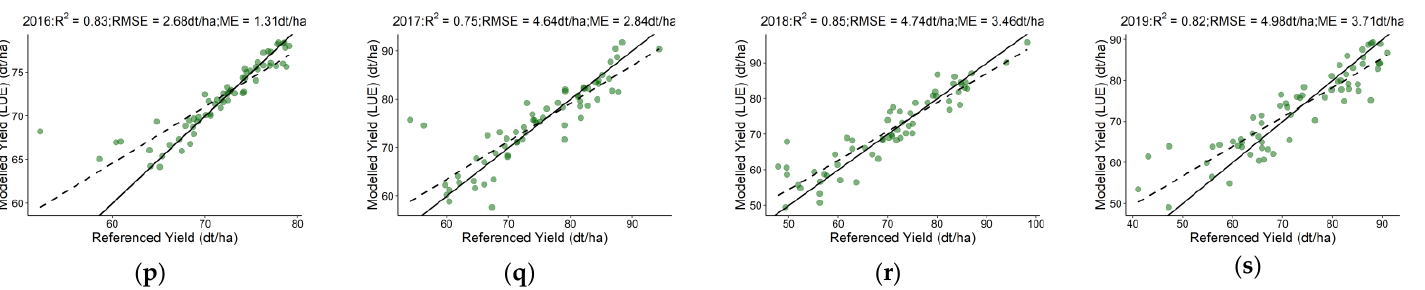
Figure A3. The scatter plots ( a – s ) compare the accuracies of modelled and referenced yields of WW for 2001 to 2019. The values of the statistical parameters such as R 2 , RMSE (dt/ha), and ME (dt/ha) are displayed at the top of each plot. Every plot contains a solid line (1:1 line) that is used to visualise the correlation of pixels between the modelled and referenced yield values. The green colour of scatter plots represents WW.